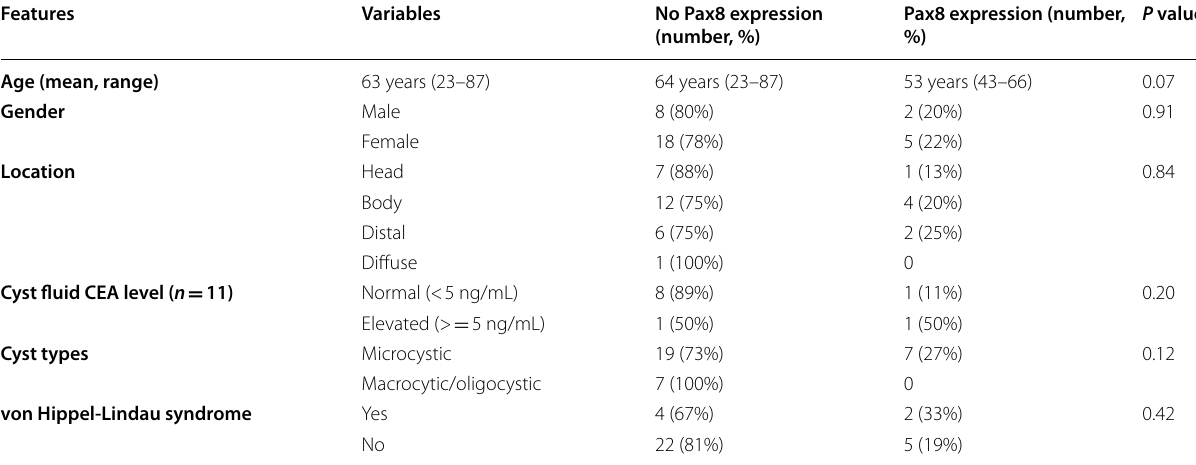
Table 3 Clinicopathological features of 33 patients with pancreatic serous cystadenoma with or without Pax8 expression